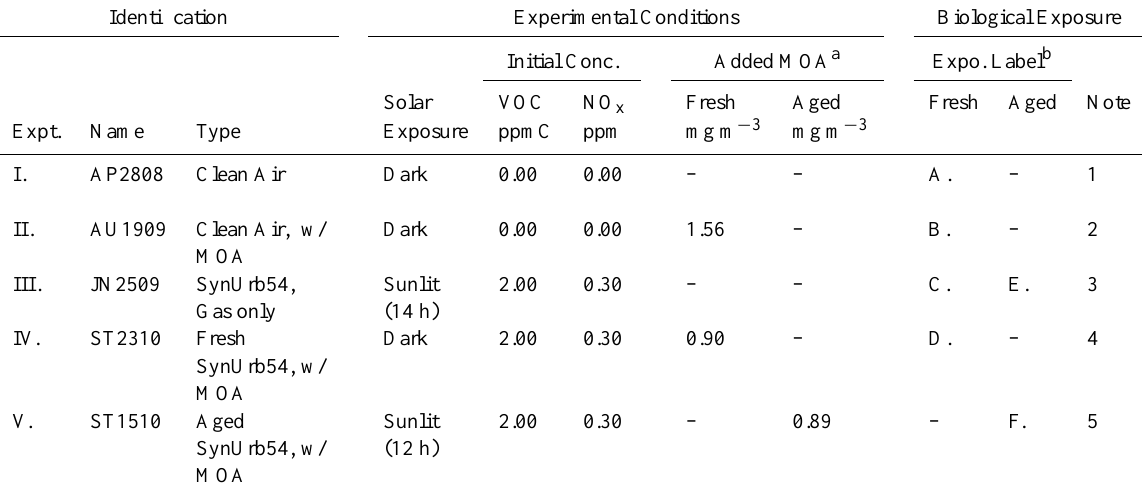
Table 2. Chamber Experimental Runs and Relevant Conditions.